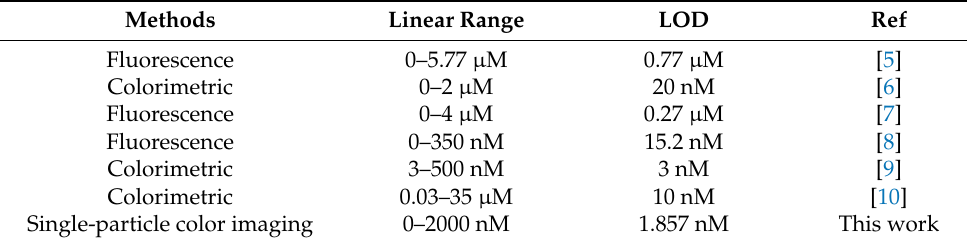
Figure 4. Representative DFM images of concave cube Au nanoparticles ( A ) before and ( B ) after incubated with Hg 2+ and AA. The DFM color image was split into three corresponding red, green, and blue channels. The (G+B)/R ratio reflects the color variation. Table 1. Comparison of detection performance of the methods for Hg 2+